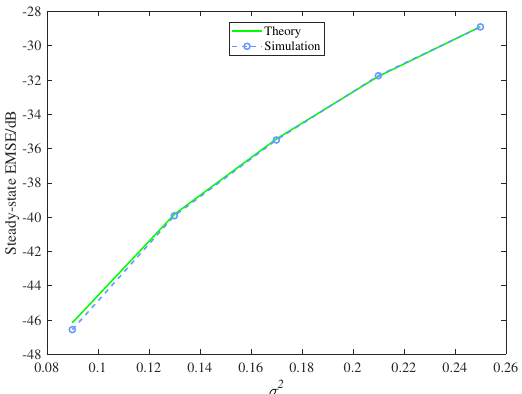
Figure 4. Theoretical and simulated steady-state EMSEs with different